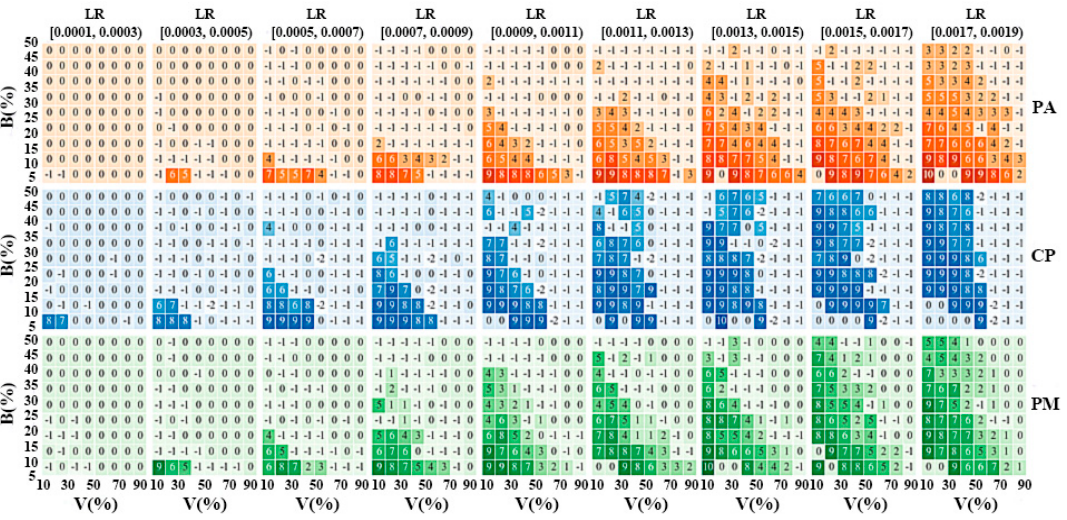
Figure 4. Heat maps showing the contribution scores of the tested hyper-parameter sets. The number shown in each grid of heat maps means the average contribution score of tested hyper-parameter sets which were randomly chosen within the given range. The heat maps in di ff erent colors denote three TLS datasets (orange: PA, blue: CP, green: PM). LR: learning rate, which was tested within [0.0001, 0.0019). V: validation split rate, which was tested within the range [10%, 90%). B: batch size, as a percentage of the number of all training samples in one batch, which was randomly selected within [5%,